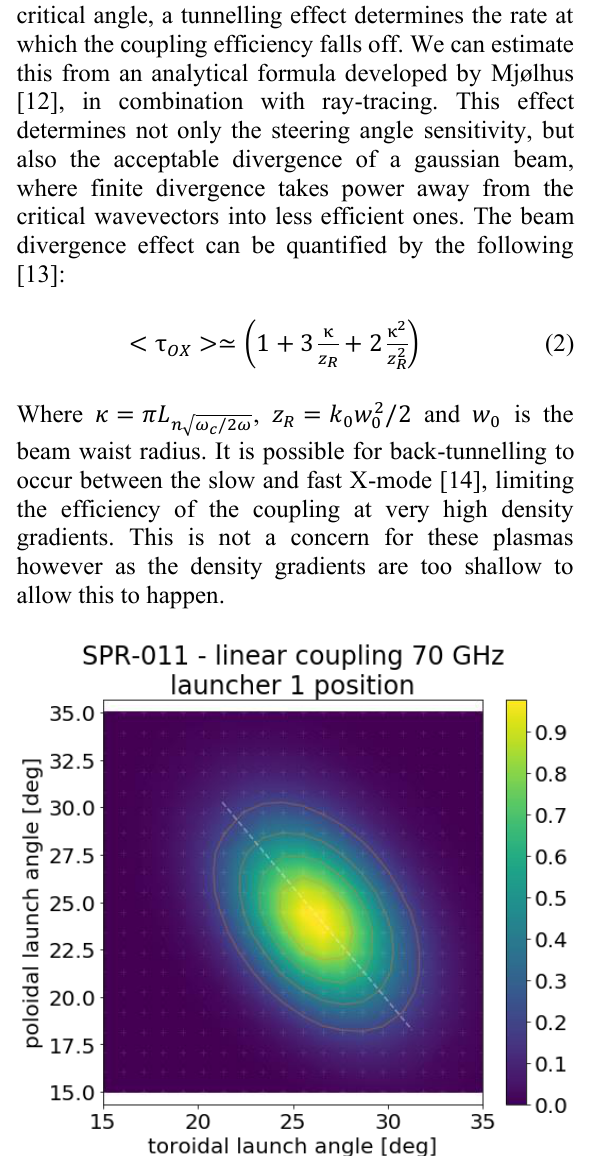
Fig. 7 : An example of the coupling window for SPR-011 at 70 GHz, for a launching mirror placed 1 m from the plasma surface at the mid-plane. Calculations are for a single ray.